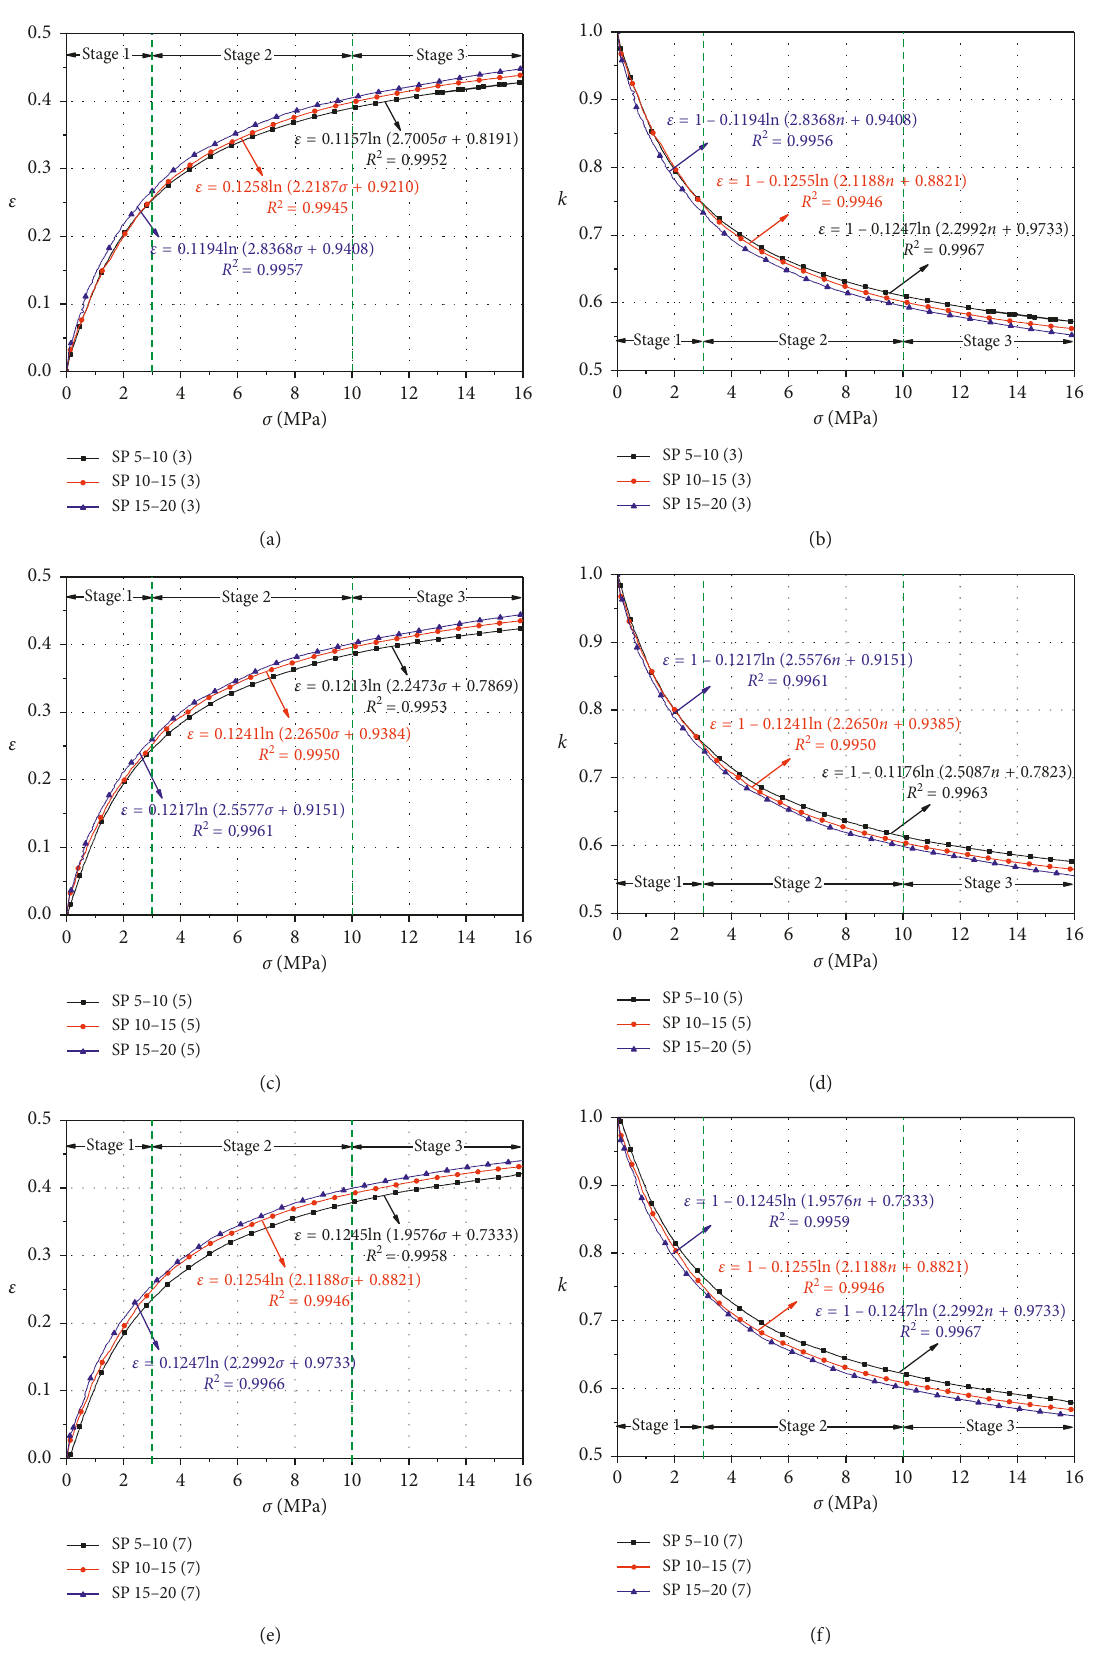
Figure 5: Compaction characteristics of coal gangues with different particle sizes following immersion at particular pH values: (a) pH � 3: σ – ε ; (b) pH � 3: σ – k ; (c) pH � 5: σ – ε ; (d) pH � 5: σ – k ; (e) pH � 7: σ – ε ; (f) pH � 7: σ – k